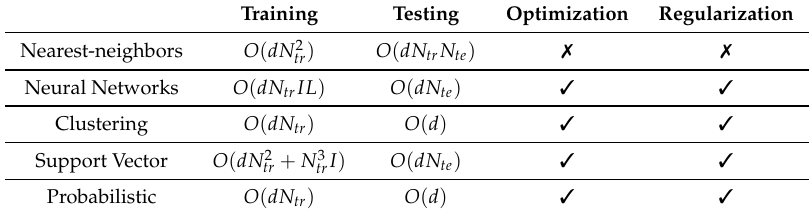
Table 4. Comparison of the computational complexity of neural network-based approaches and others. Training Testing Optimization